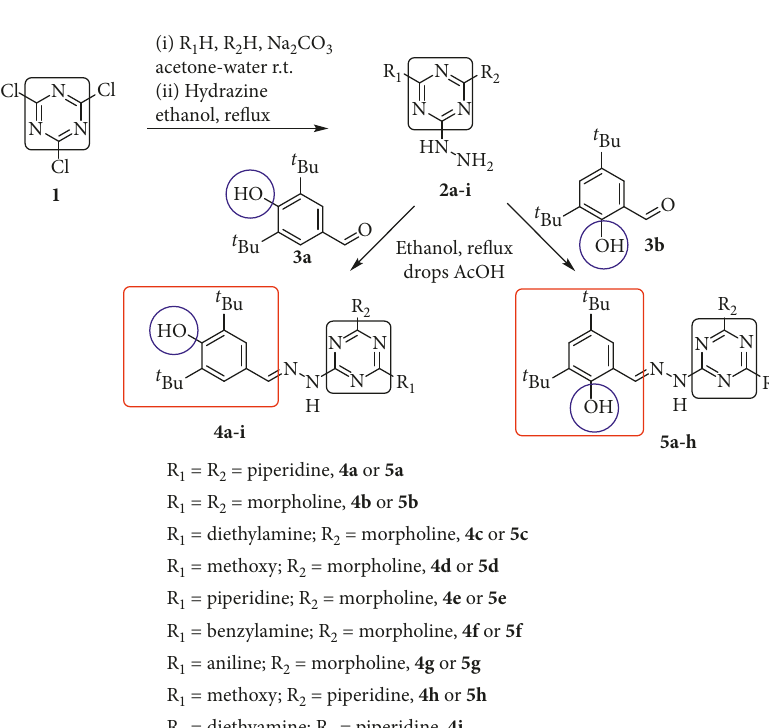
Scheme 1: Synthetic route for preparation of s-triazine Schiff-base derivatives.